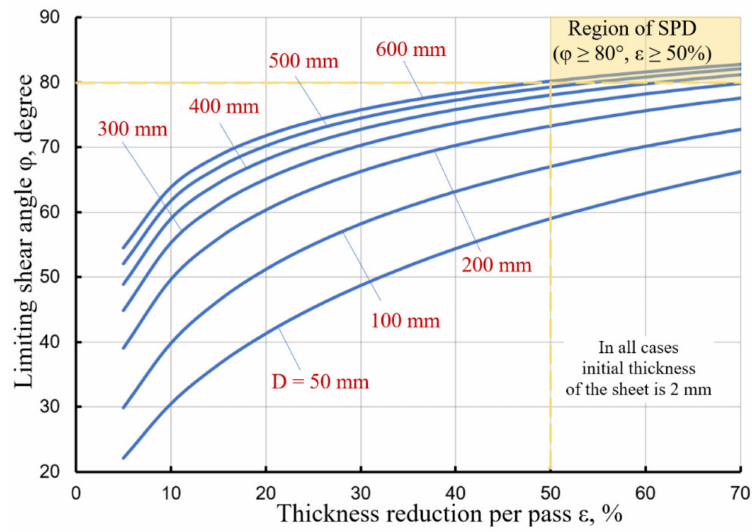
Figure 29. Influence of diameter D of work rolls and thickness reduction per pass ε on limiting shear angle ϕ during asymmetric